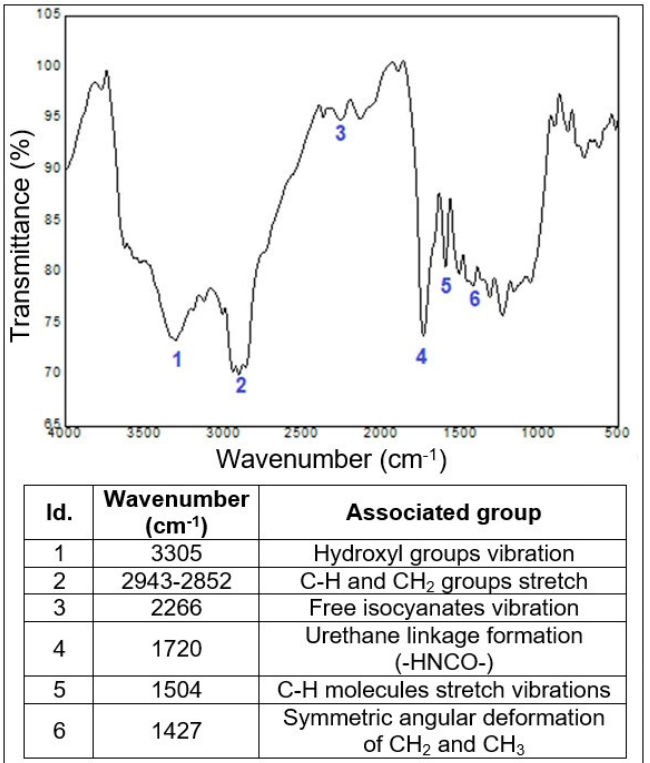
Figure 9. FTIR spectra for the luffa/COPU composite.